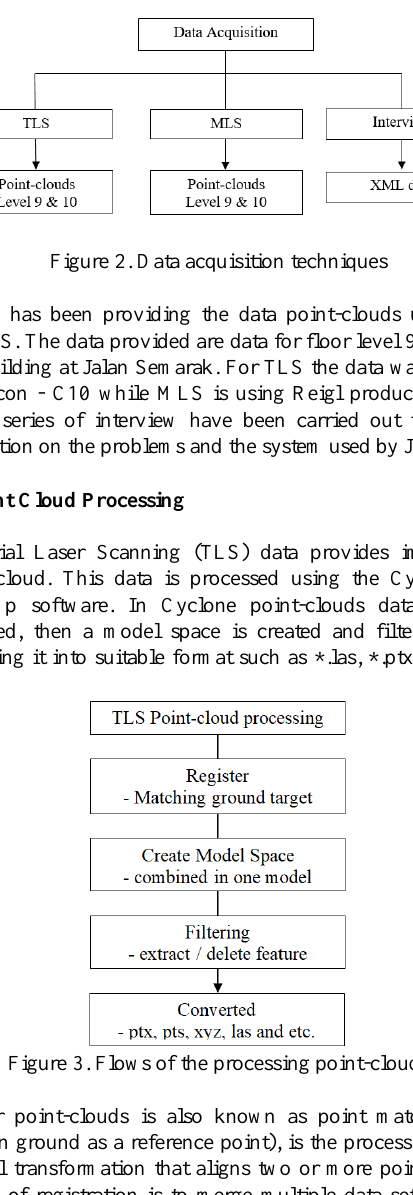
Figure 1. General flows of the methodology